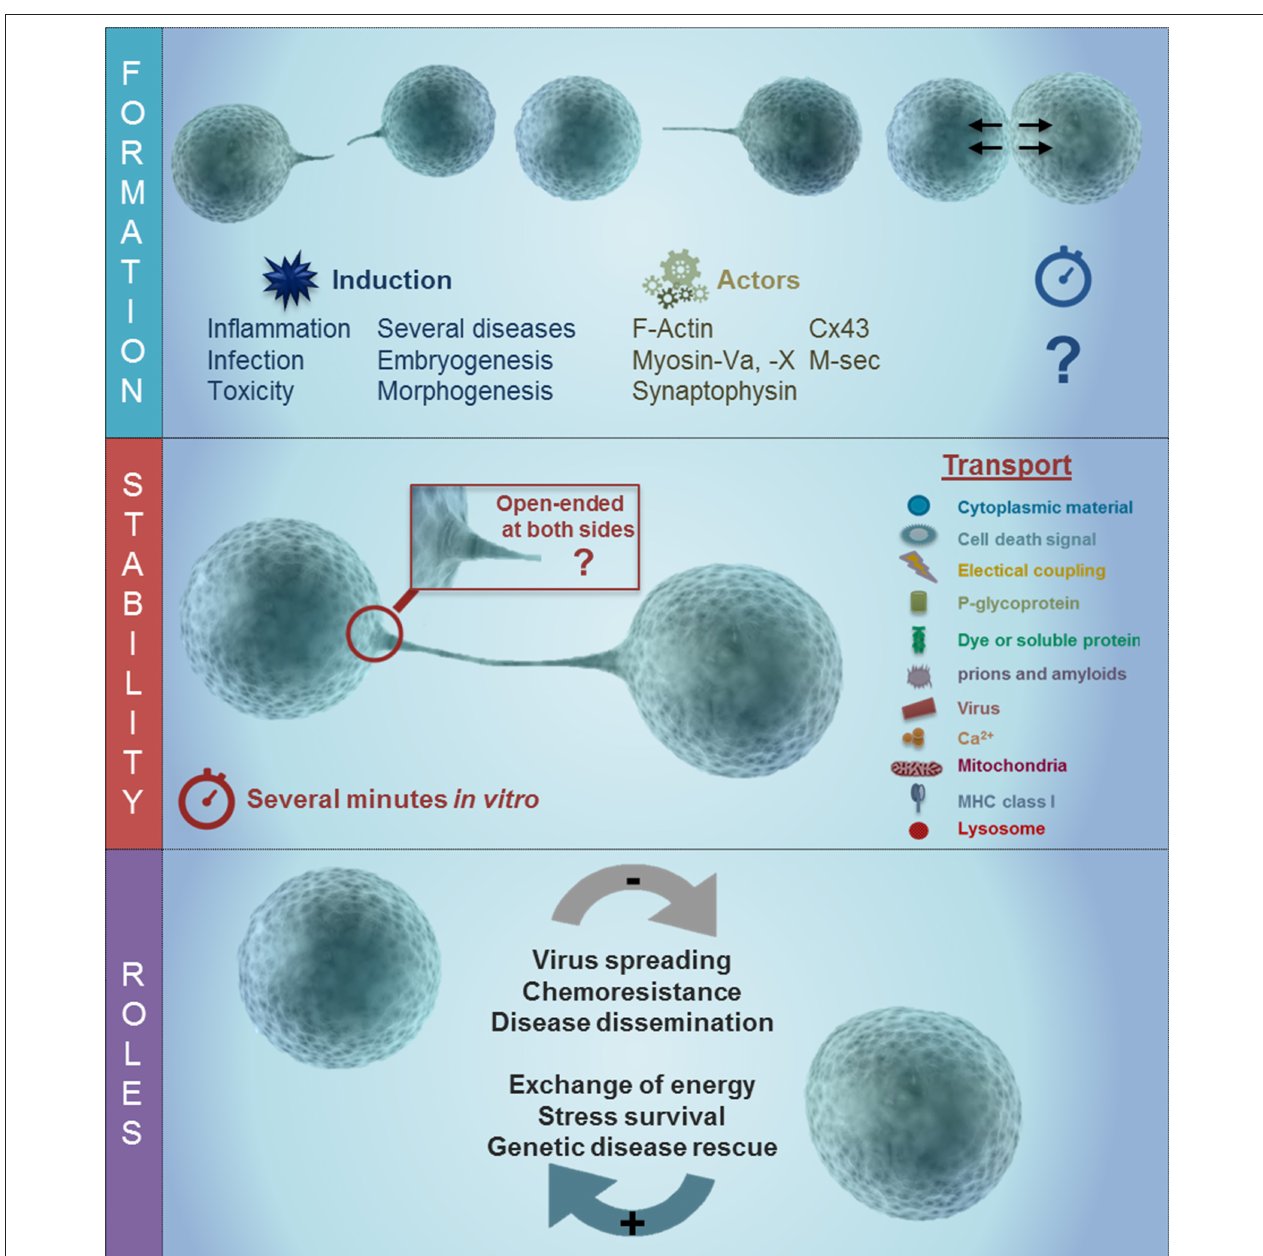
FIGURE 1 | Schematic of TNT formation and the potential role of gap junction channels during long rage communication. As described in the text, TNT have at least 3 different stages, including formation, stabilization, and the transport of the cargo. The last one is associated with several different roles in disease including viral spreading, chemoresistance, and disease dissemination as well as an energy associated survival, genetic disease rescue and stress survival. TNT formation is triggered by inflammation, infection, toxicity, in several disease, and embryogenesis/morphogenesis. Some of the proteins involved in the formation of TNT are actin, Myosin Va and X, synaptophysin, Cx43, and M-sec. Following the formation of the TNT process, there are at least 2 different types of tubes, a synaptic and open-ended process. The formation of these long rage TNT enable the connected cells to share multiple proteins and